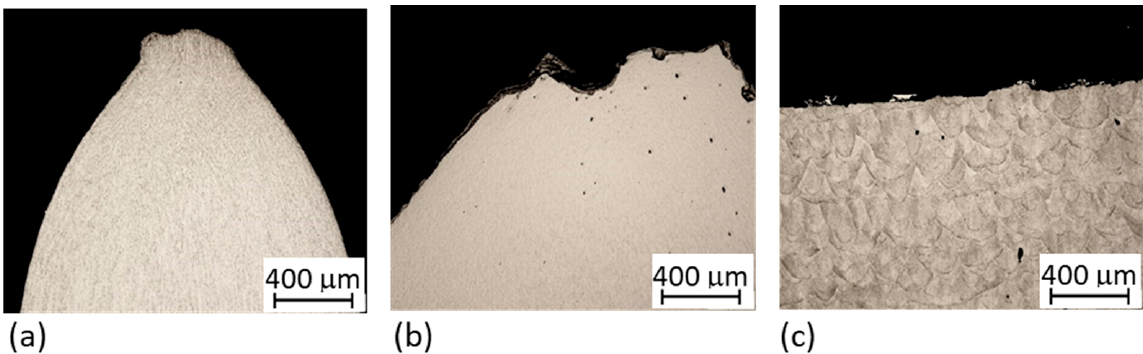
Figure 15. Metallographic longitudinal sections through fractured bars (the fracture area is at the top), showing the distance of the fracture from the MS1/VACO 180 interface for hybrid parts: ( a ) without heat treatment; ( b ) in the solution annealed condition; and ( c ) precipitation annealed con ‐ ditions.